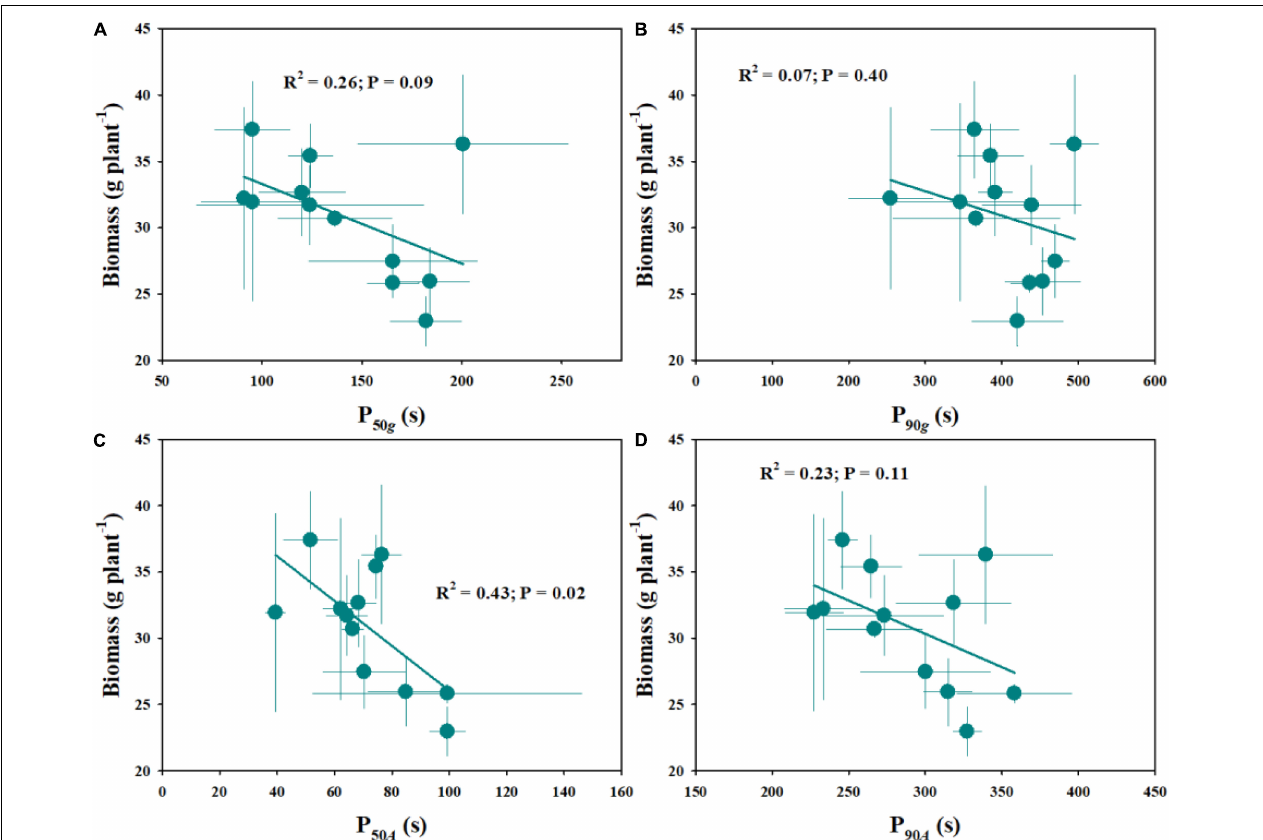
FIGURE 8 | Effect of stomatal kinetics (A,B) and photosynthetic induction (C,D) on plant biomass. Stomatal kinetics (P 50 g , P 90 g ), the time required for g s to reach 50 and 90% of the difference in g si and g sf ; photosynthetic induction (P 50 A , P 90 A ), the time required for g s to reach 50 and 90% of the difference in A i and A f . Points and error bars represent the mean ± SD of three